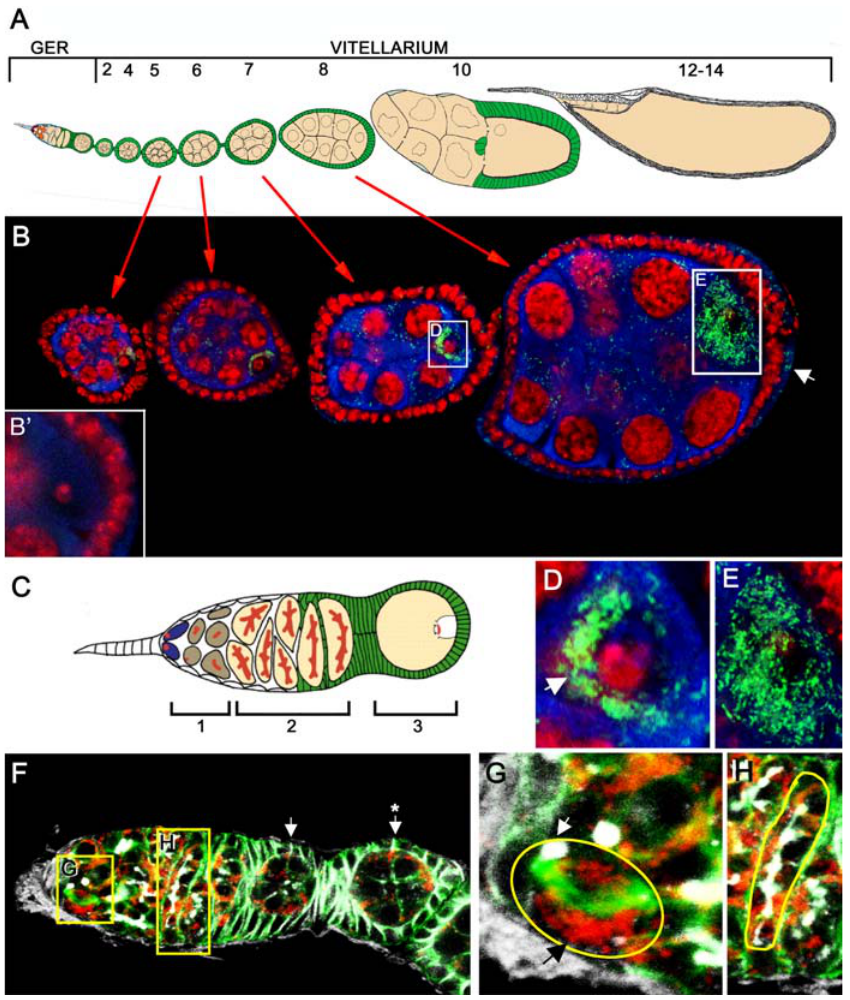
Figure 1. Wolbachia Distribution from Germ-Line Stem Cell Division through Mid-Oogenesis In (B), (B 9 ), (D), and (E), Wolbachia is green (hsp60), Vasa is blue, and DNA is red. In (F–H), Wolbachia is red (hsp60), a -Spectrin highlights the fusome (white), and microtubules are green. (A) The ovariole consists of the germarium (GER) at the anterior-most tip, and the vitellarium. Numbers represent the stages of oogenesis in the vitellarium (stages 2 through 14). Between stages 2 and 7, the cytoplasm of the nurse cells and the oocyte increases linearly. Following stage 7, the oocyte cytoplasm begins to grow disproportionately faster than nurse cell cytoplasm. Between stages 10 and 12, all nurse cell cytoplasm is transferred into the oocyte through ‘‘ cytoplasmic dumping. ’’ From stage 12 to 14, the nurse cell nuclei degenerate and dorsal filaments are formed. (B) Middle stage egg chambers infected with Wolbachia . White arrow indicates Wolbachia within follicle cells. (B 9 ) High magnification of a stage 5 uninfected oocyte stained with anti-hsp60 antibody, showing that this antibody does not cross react with D. melanogaster proteins. (C) The germarium is divided into regions 1, 2, and 3. In the germarium, a germ-line stem cell (dark blue) divides to produce a daughter stem cell and a cystoblast. In region 1, the cystoblast is mitotically active; it undergoes four successive rounds of mitosis, resulting progressively in cysts of two, four, eight (brown), and sixteen (tan) cystocytes. Red shading represents the fusome. In region 2, the 16-cell cyst becomes surrounded by somatically derived follicle cells (green). At the most posterior position of the germarium (region 3), the stage 1 cyst buds off and enters the vitellarium. By this time the oocyte (white) has moved to the posterior side of the cyst. (D) High magnification of a stage 6 oocyte. Wolbachia (indicated by a white arrow) accumulate densely around the anterior of the oocyte. (E) High magnification of a stage 7 oocyte. Wolbachia begin to disperse from the anterior of the oocyte. (F) A germarium infected with Wolbachia : stage 1 egg chamber (white arrow) and stage 2 egg chamber (white arrow with asterisk). (G) High magnification of a germ-line stem cell (circumscribed by yellow line) undergoing asymmetric mitosis. The fusome material (indicated by a white arrow) is spherical in the stem cell. A cystoblast is visible in the upper right corner, identified by its shape and position in the germarium. A black arrow indicates Wolbachia . (H) A 16-cell cyst in region 2 of the germarium (circumscribed by yellow line) as it becomes surrounded by follicle cells. Wolbachia are present in all of the germ cells, but do not associate with the fusome. (A) adapted from [79]; (C) adapted from [39]. DOI: 10.1371/ journal.ppat.0010014.g001 8-, and 16-cell cysts (Figure 1F and 1H), indicating that the Wolbachia establish an early presence in the cell destined to become the oocyte. bacteria are efficiently passed from the stem cell to each of the interconnected germ cells of the cyst. By distributing In region 2 of the germarium, one of the two germ cells evenly among all 16 germ cells prior to oocyte differentiation, with four ring canals differentiates into the oocyte, while the PLoS Pathogens |